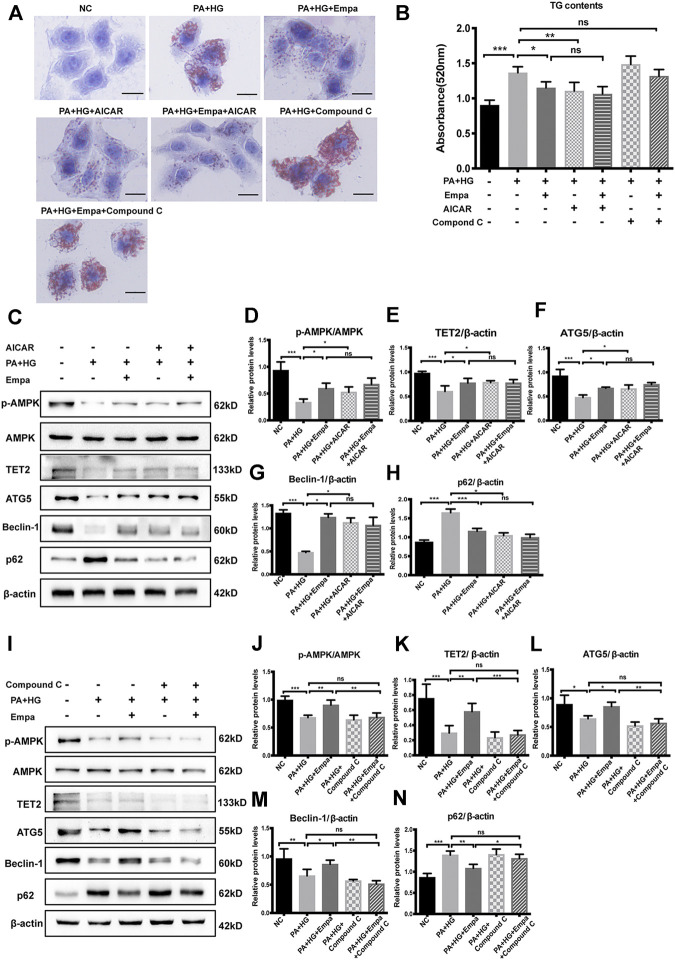
The increase in TET2 and autophagy and reduction in lipid accumulation by empagliflozin are dependent on AMPK activation. HL7702 cells were treated with or without PA and HG, with or without empagliflozin, in the presence or absence of AICAR or compound C (A) Representative images of Oil Red O staining and (B) quantitative analysis of TGs. Scale bar represents 30 μm (C, I) Western blot analyses of p-AMPK, AMPK, TET2, ATG5, Beclin-1, and p62 with β-actin as a loading control and (D–H, J–N) densitometric analyses of band intensities normalized to β-actin. Data in (B, D–H, J–N) are presented as means ± SEM from three independent experiments. Empa, empagliflozin; HG, high glucose; NC, negative control group; ns, not significant; PA, palmitic acid; TG, triglyceride. *p < 0.05, **p < 0.01, ***p < 0.001.